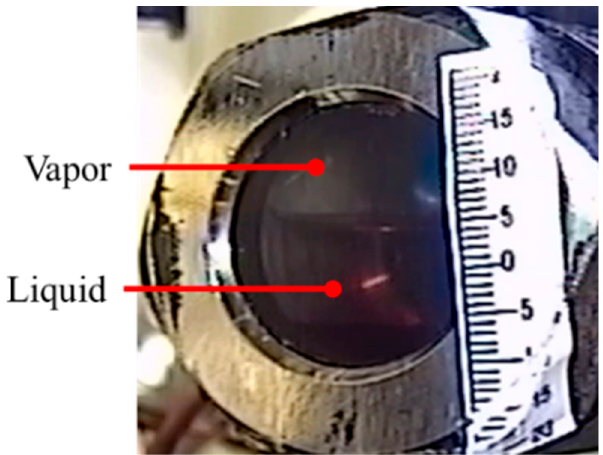
Figure 8. Photos of the sight glass on the accumulator shell before startup.